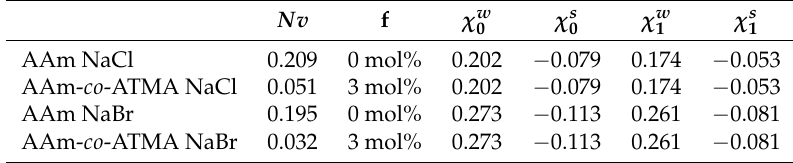
Table 1. Optimized model parameters assuming 3 mol% ATMA in the charged